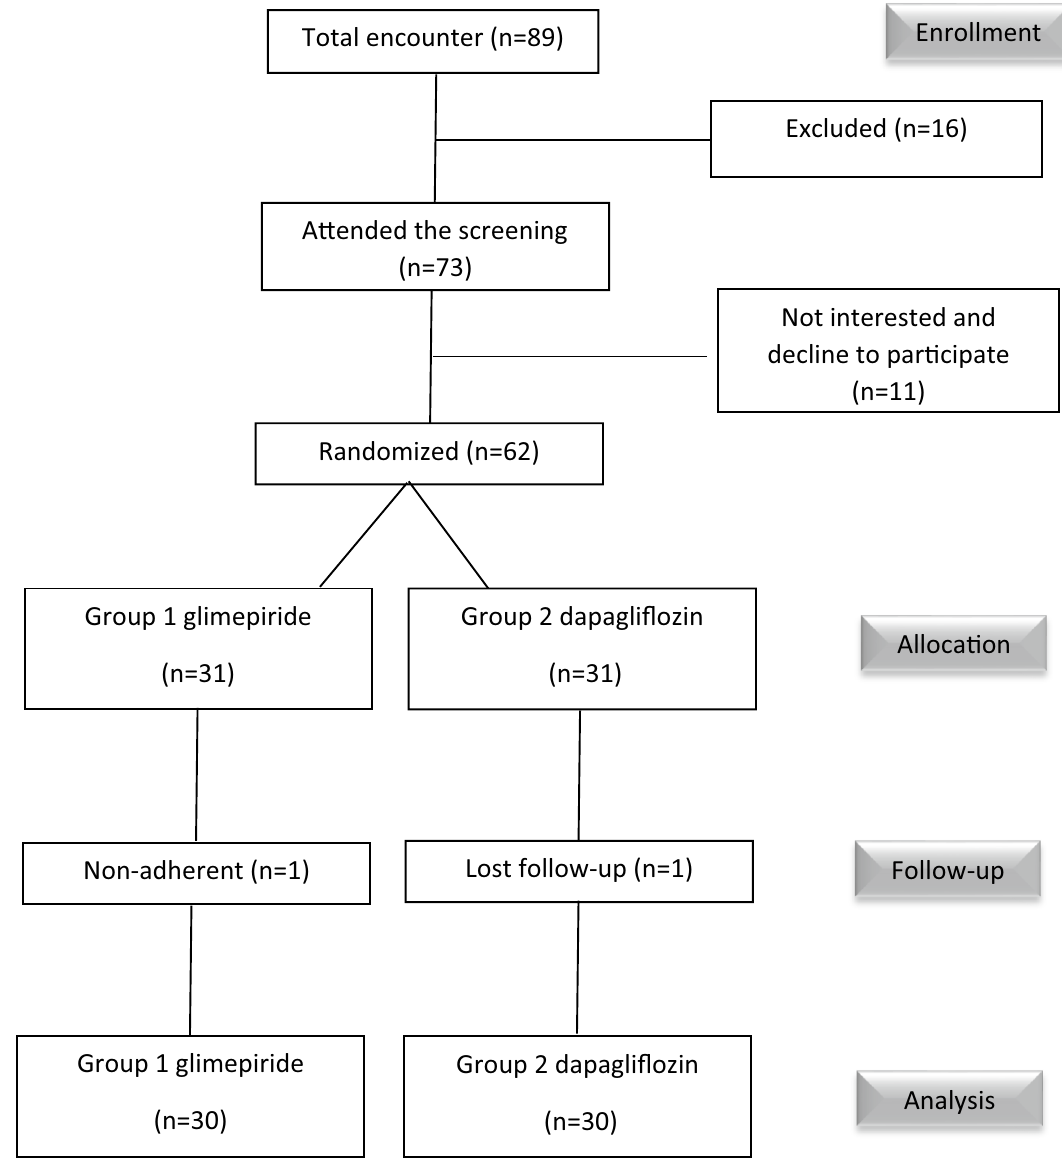
Figure 1. Flow-chart for study participants screening, enrollment, randomization, and follow-up.